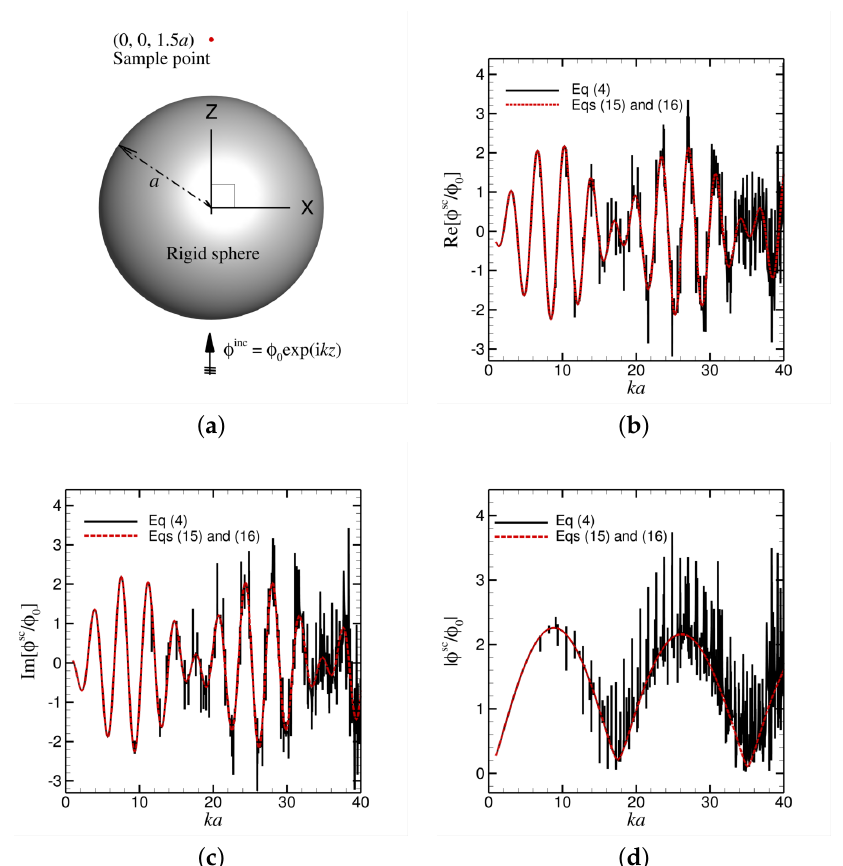
Figure 2. Scattering on a rigid sphere with radius a used as a test case. ( a ) The incoming plane wave moves upwards and the observation point is behind the sphere at a distance of 1.5 a from the centre of the sphere. ( b ) The results of the real part of the potential φ sc with the non-singular Burton–Miller formulation (in red) as a function of ka . The results of the non-singular standard boundary element method are also indicated (in black); 5762 nodes with 2880 quadratic triangular elements were used. ( c , d ): as ( b ) but for the imaginary part of φ sc and the absolute value of φ sc ,